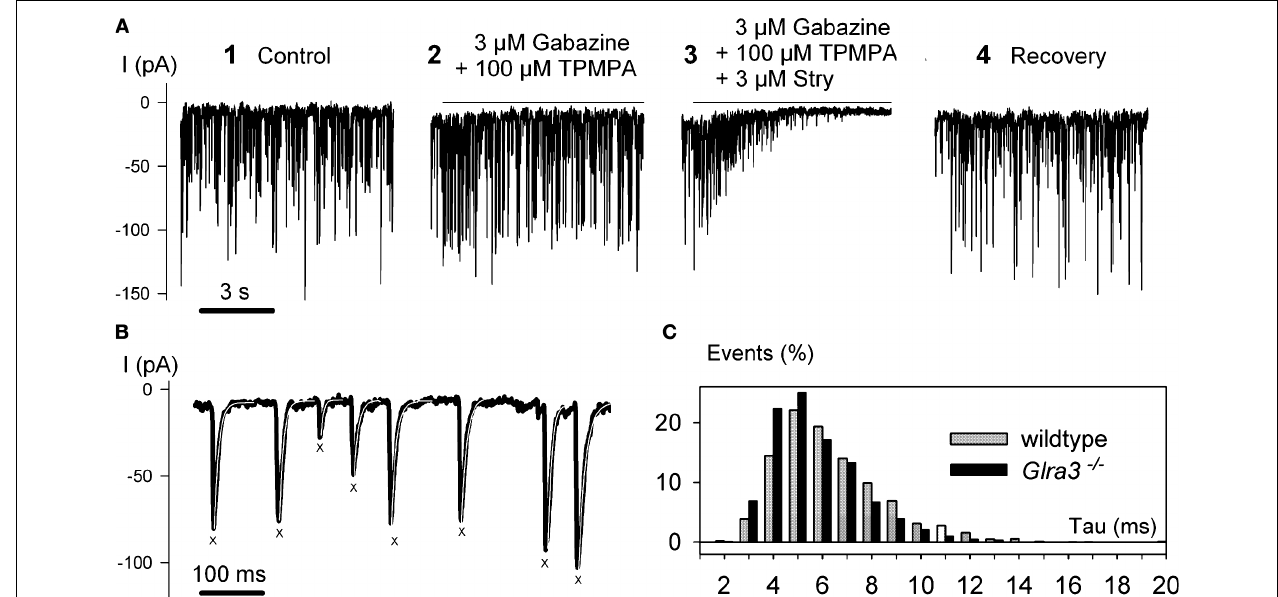
FIGURE 6 | Recordings of spontaneous IPSCs from OFF-CB cells of the mouse retina (modifi ed from Ivanova et al., 2006). (A) At a holding potential of V = − 50 mV, large sIPSCs were recorded (1). Co-application of the GABAR H antagonists gabazine and TPMPA (1,2,5,6 tetrahydrpyridine-4-yl- methylphosphonic acid) did not block the IPSCs (2). However, co-application of GABAR antagonists and strychnine (Stry) abolished the IPSCs (3). (B) IPSCs